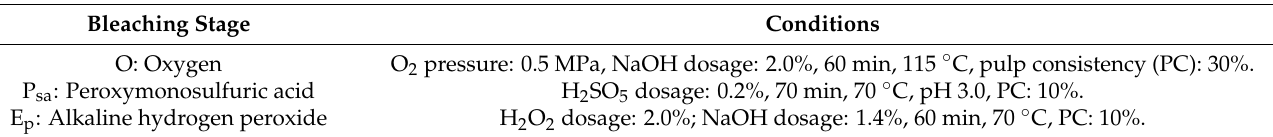
Table 4. Conditions of three-stage totally chlorine-free bleaching for Nypa fruticans frond soda pulp. Bleaching Stage